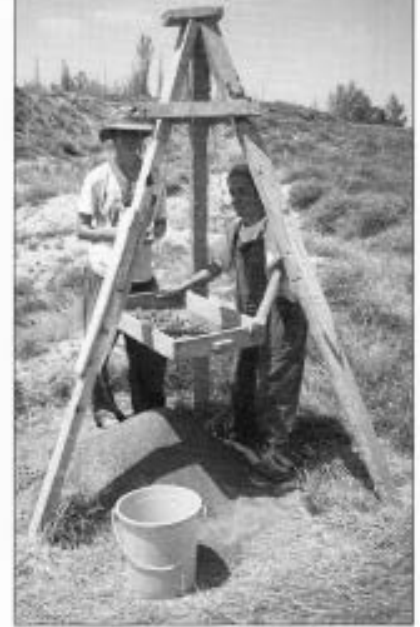
Figure 4 Sieving archaeological depos­ its on site to retrieve small objects.